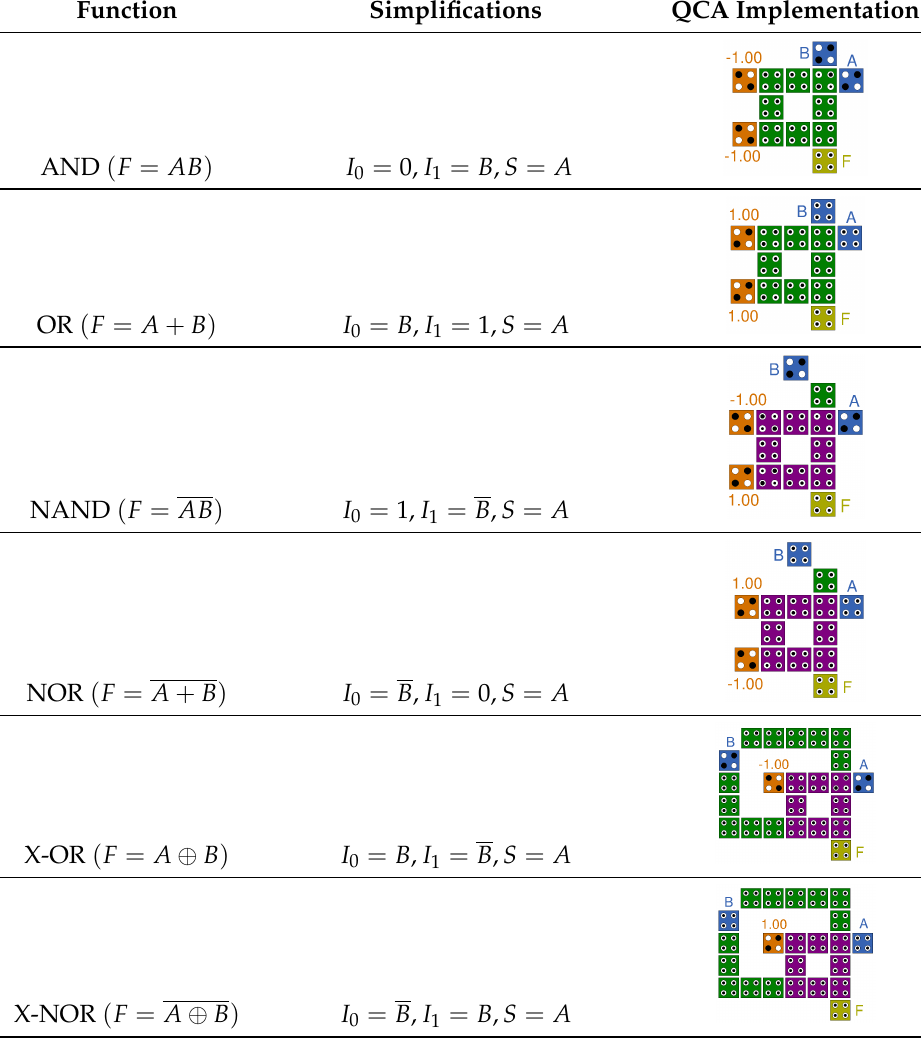
Table 1. Implementation of basic 2-input logic functions using